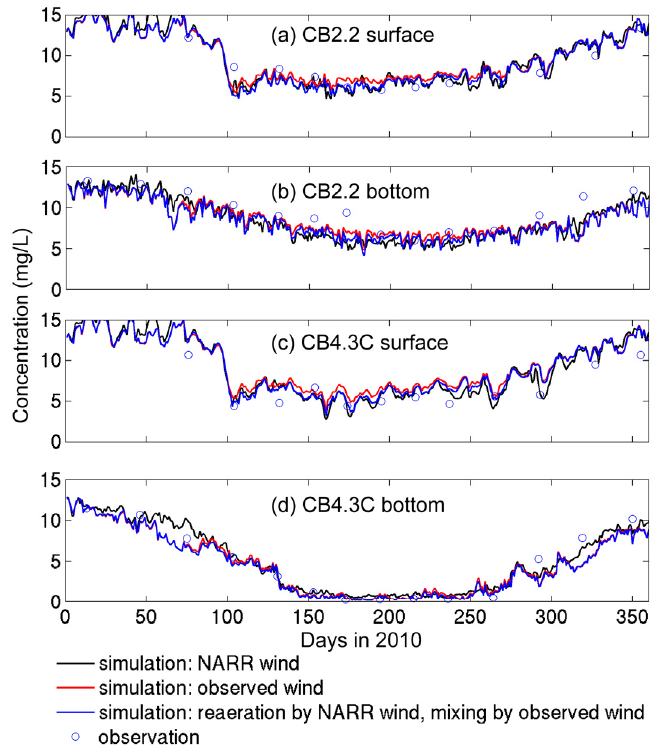
Figure 9. Time series of observed (open dots) and simulated (black solid line, results driven by the NARR wind data; black dashed line, results driven by the observed wind data (Table 2); blue dashed line, results using NARR wind-driven mixing and observed wind-driven reaeration) dissolved oxygen at two sampling sites in Chesapeake Bay (Figure 1) in 2010: Station CB2.2 at ( a ) the surface and ( b ) the bottom; Station CB4.3C at ( a ) the surface and ( b ) the bottom.